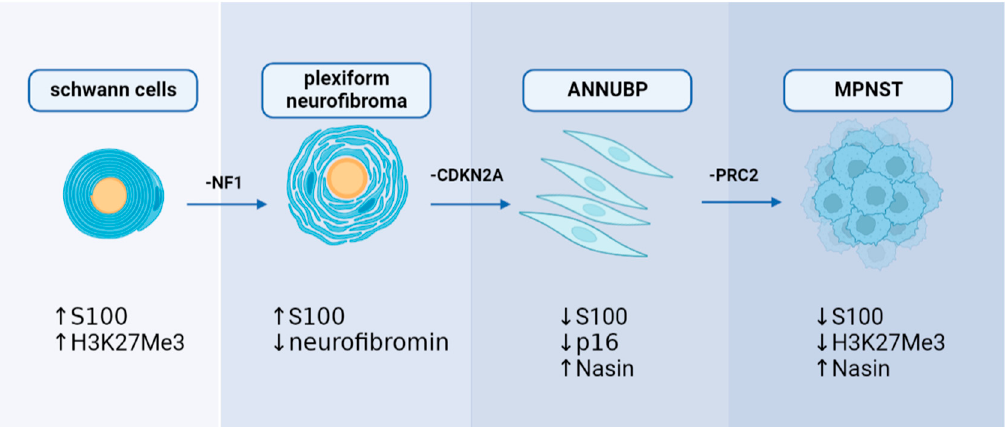
Figure 3. A hypothesis of sequential, multiple-hit genetic mutations in MPNST development: NF1 , CDKN2A , and PRC2 may play a decisive role in MPNST development with alterations in immunohistochemical markers.